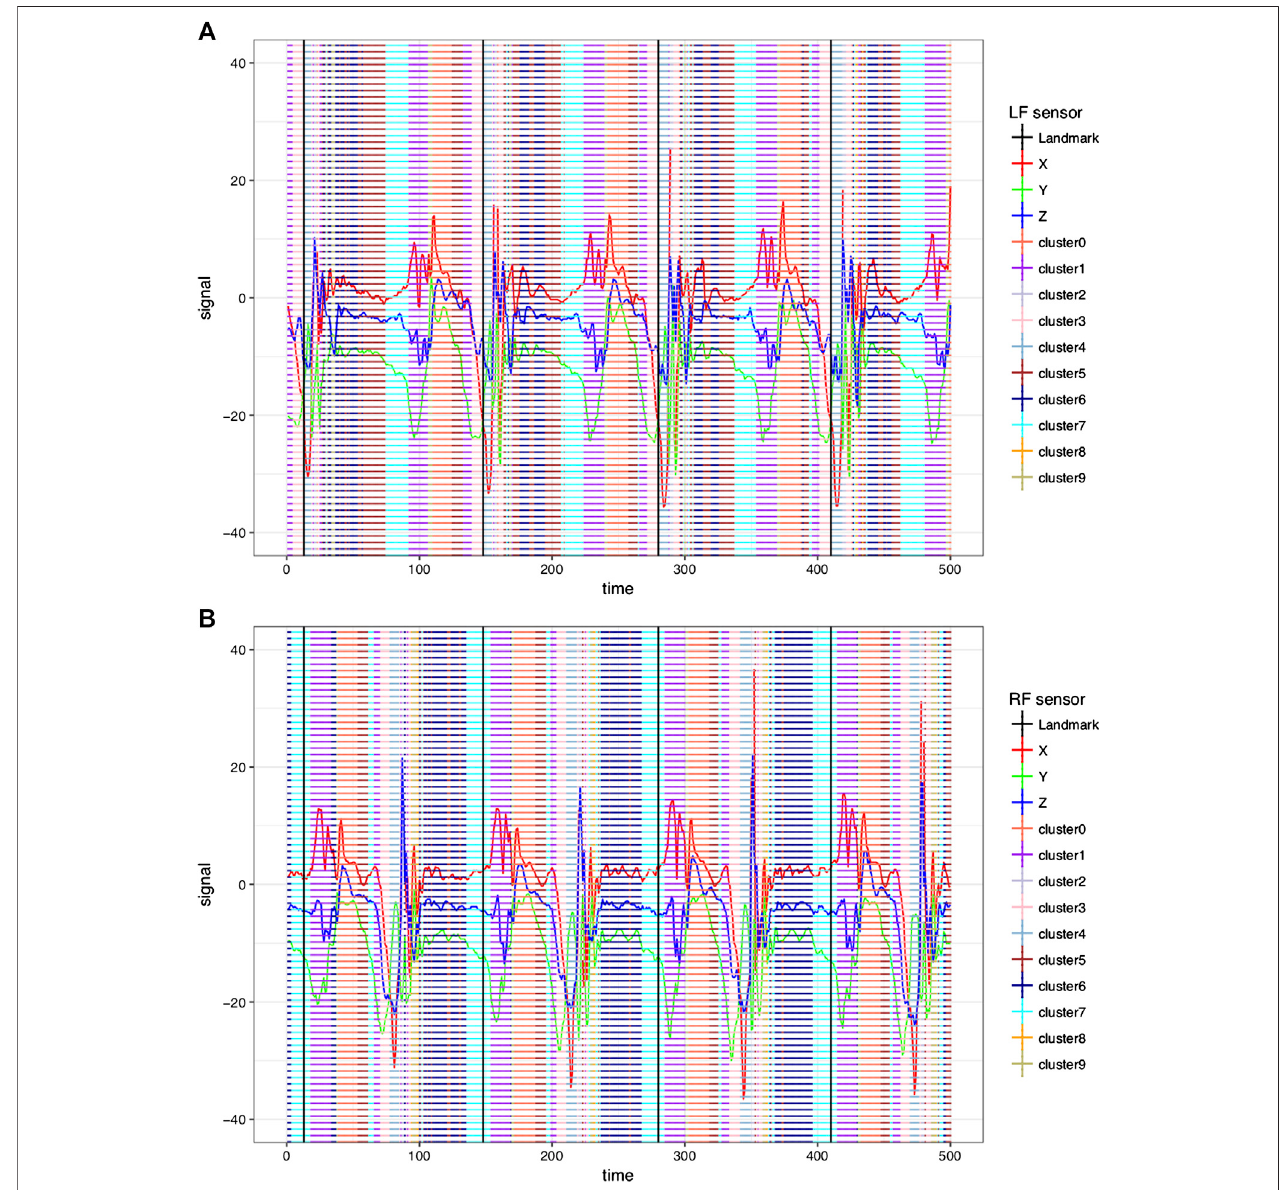
FIGURE 4 | 3D time series superimposed with color coding on temporal period [1, 500]. (A) Left-foot sensor and (B) right-foot sensor. Color coding of the 10 selected clusters are listed on the right hand side. The landmarks are calculated and marked with vertical black line.